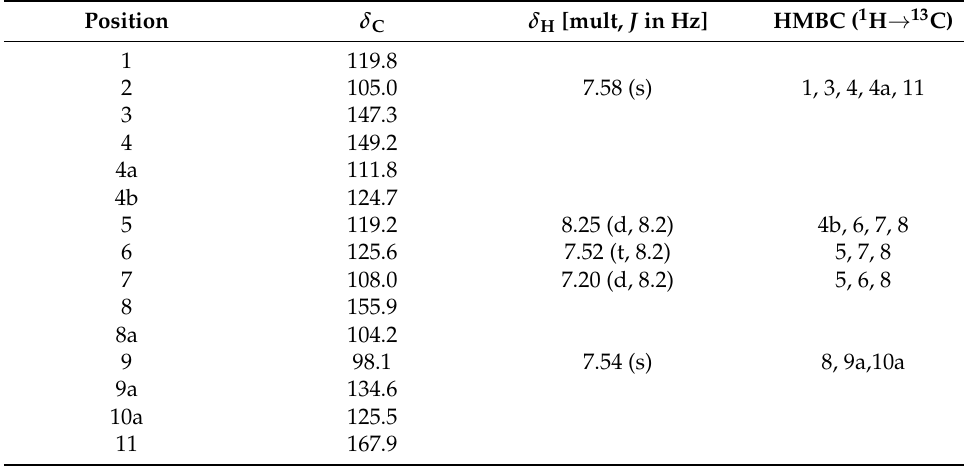
Table 1. 1 H (600 MHz) and 13 C (150 MHz) NMR spectroscopic data of 1 in acetone- d 6